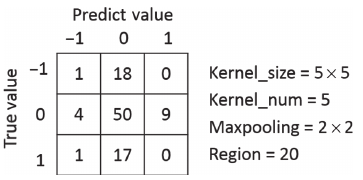
Figure 15: Confusion Matrix of Experiment 1 in Architecture 3.